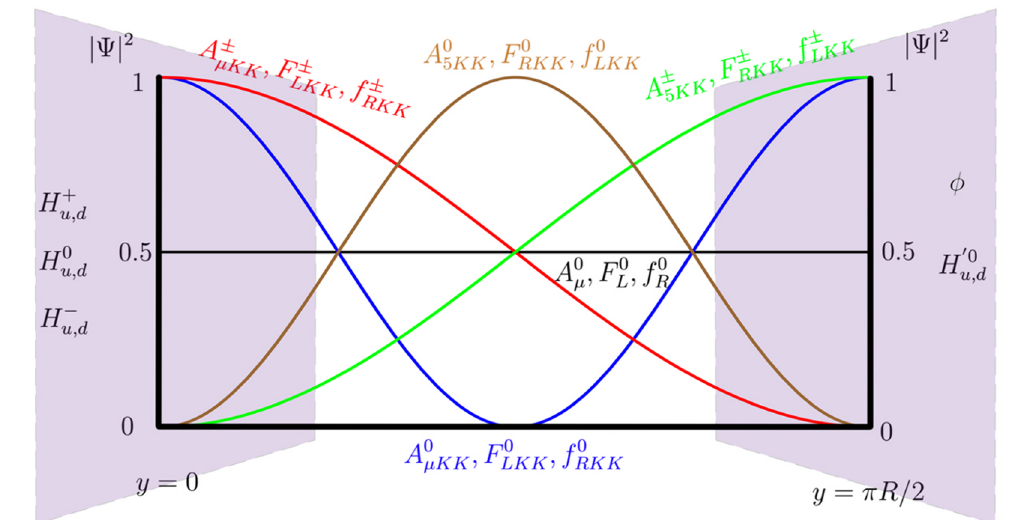
are the physically relevant Higgs doublets u,d , F 0 , f 0 are isoneutral (isocharge zero) and µ L R